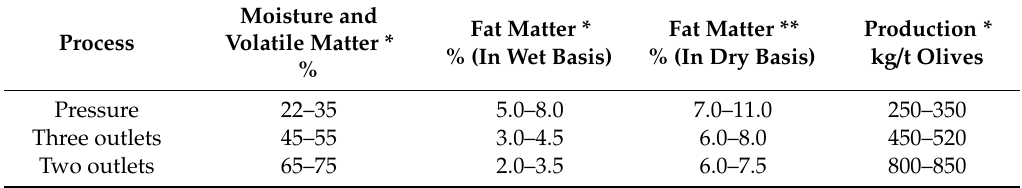
Table 5. Physicochemical characteristics of the pomaces based on the process